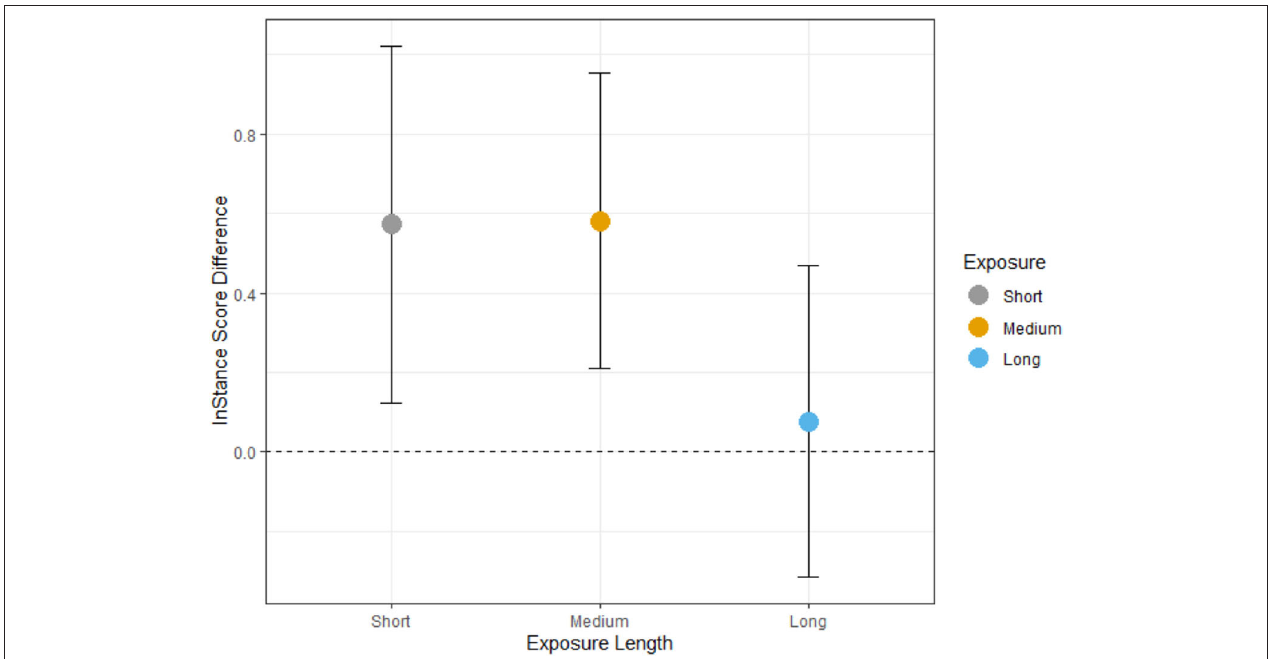
FIGURE 2 | Change in ISQ ratings after exposure. The graph illustrates the difference in pre- and post-ratings. A positive increase illustrates that the rating changed to a higher rating at post, while a zero value would indicate no changes between pre- and post-ratings. The observed ISQ difference scores show the short and medium exposure conditions show a positive increase in ISQ scores after completing of the gaze-cueing task, while the long exposure condition shows no increase.